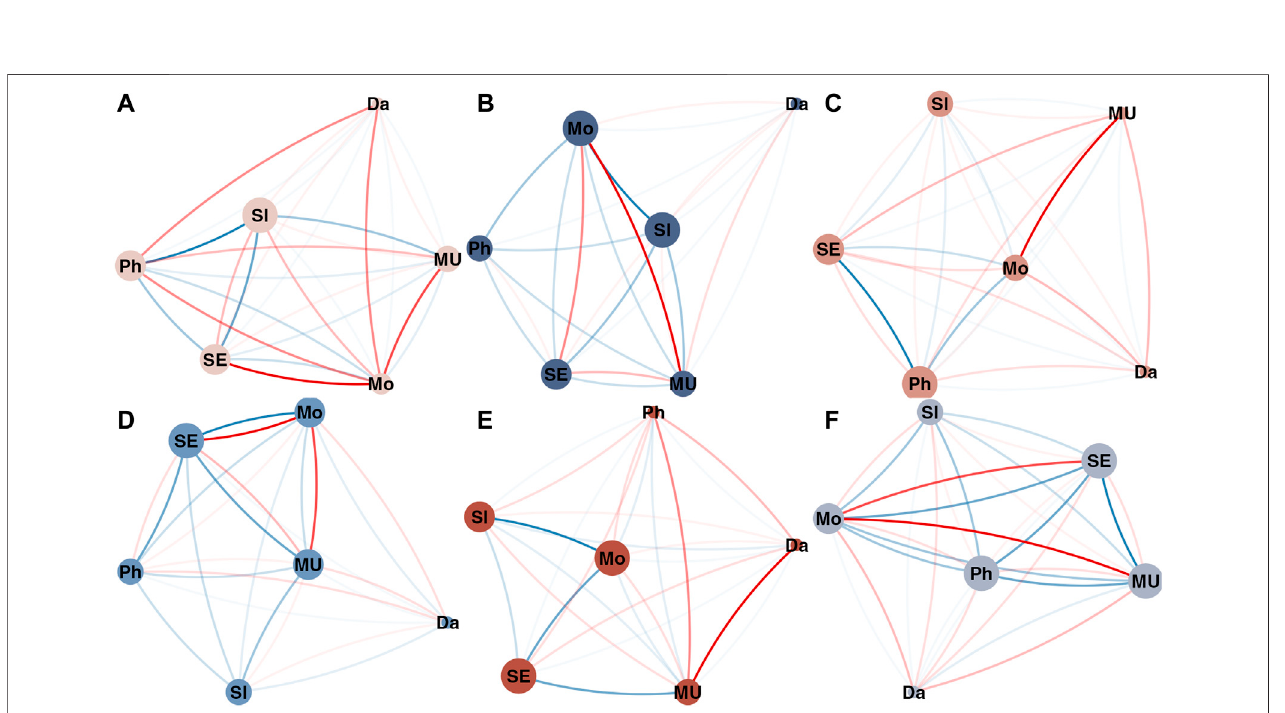
Frontiers in Physiology |